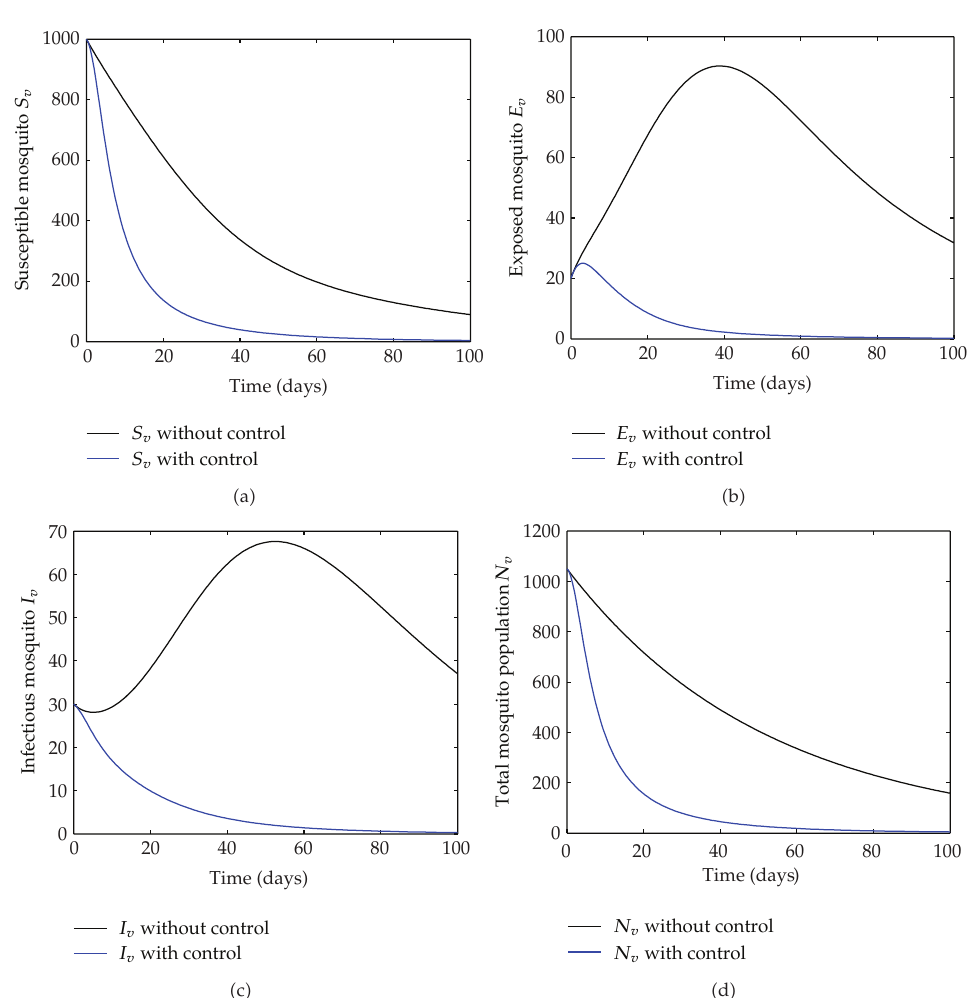
Figure 2: The plot represents population of susceptible, exposed, infected and the total number of mosquito population both with control and without